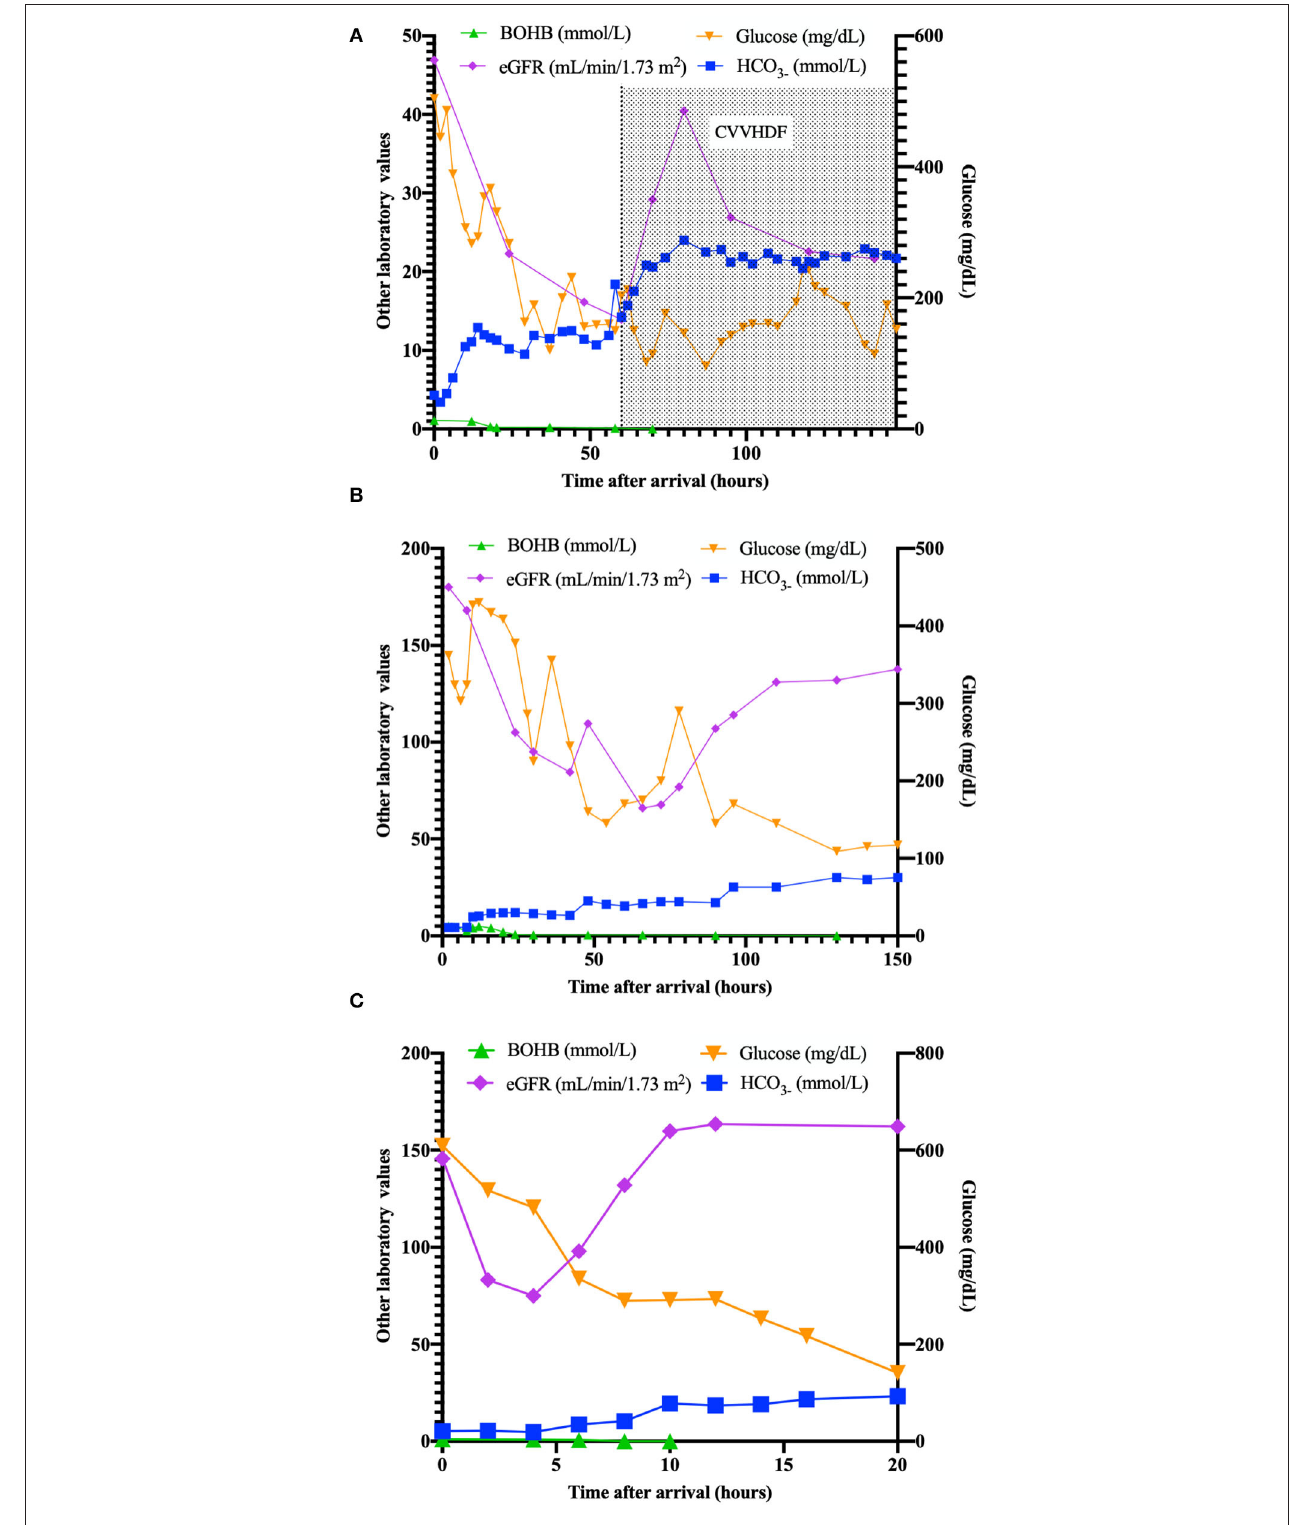
FIGURE 1 | Plasma values (ketones, eGFR, bicarbonates, glucose) in patients (A–C) in the time after arrival (hours).